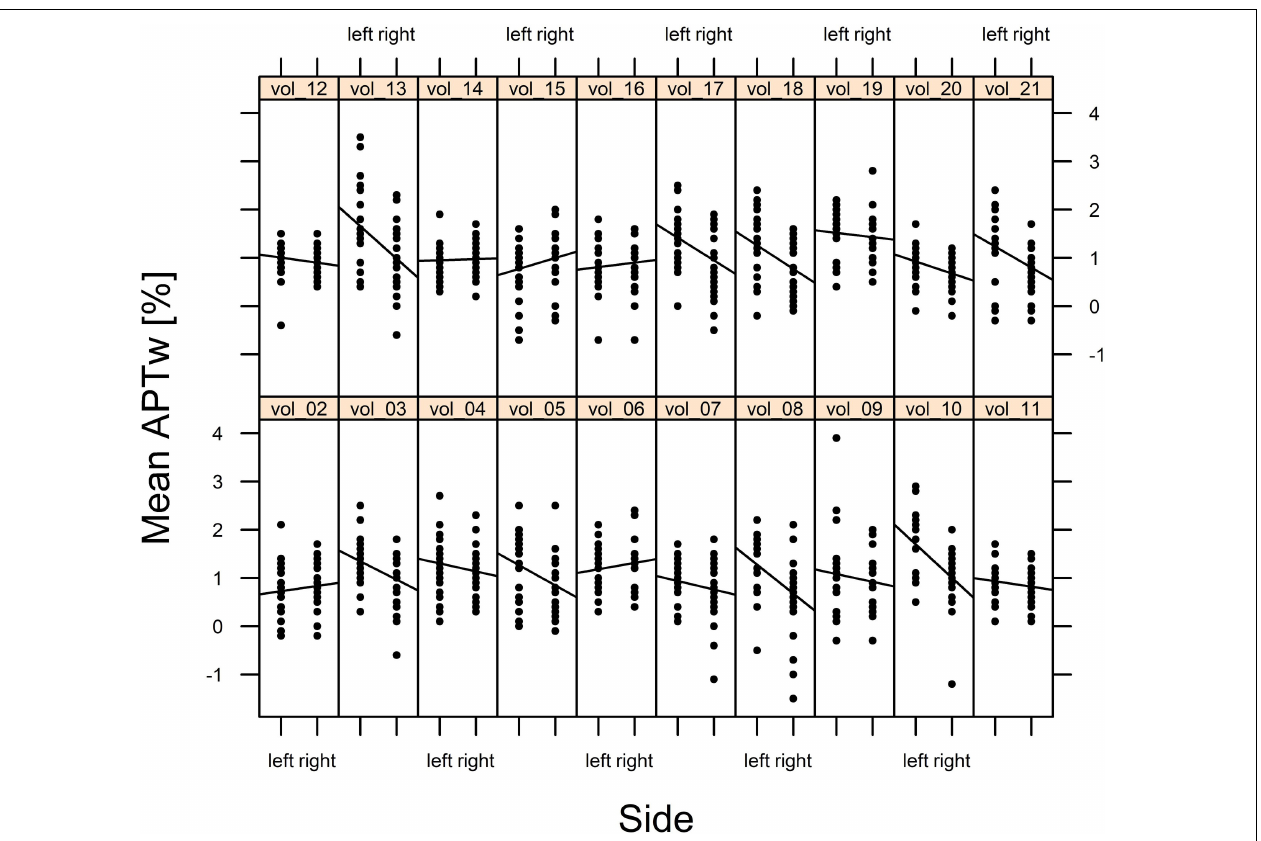
FIGURE 6 | Mean APTw intensity values of every brain region of each subject (sides separated) are